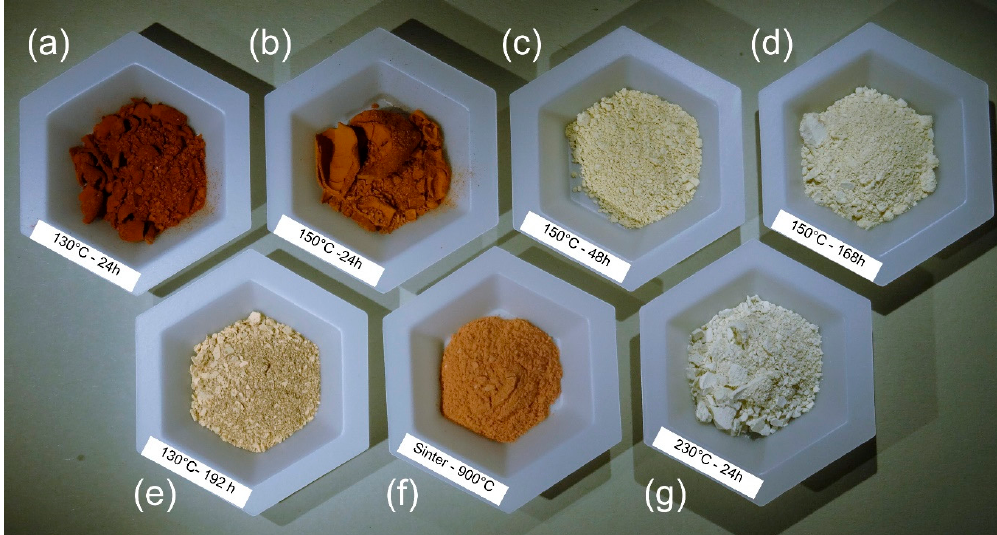
Figure 1. Comparison of color in aegirine synthesis at different temperatures and synthesis times. ( a ) sample synthesized at 130 °C and 24 h; ( b ) sample synthesized at 150 °C and 24 h; ( c ) sample synthesized at 150 °C and 48 h; ( d ) sample synthesized at 150 °C and 168 h; ( e ) sample synthesized at 130 °C and 192 h;( f ) sample synthesized by ceramic sintering at 900 °C; ( g ) sample synthesized at 230 °C and 24 h.